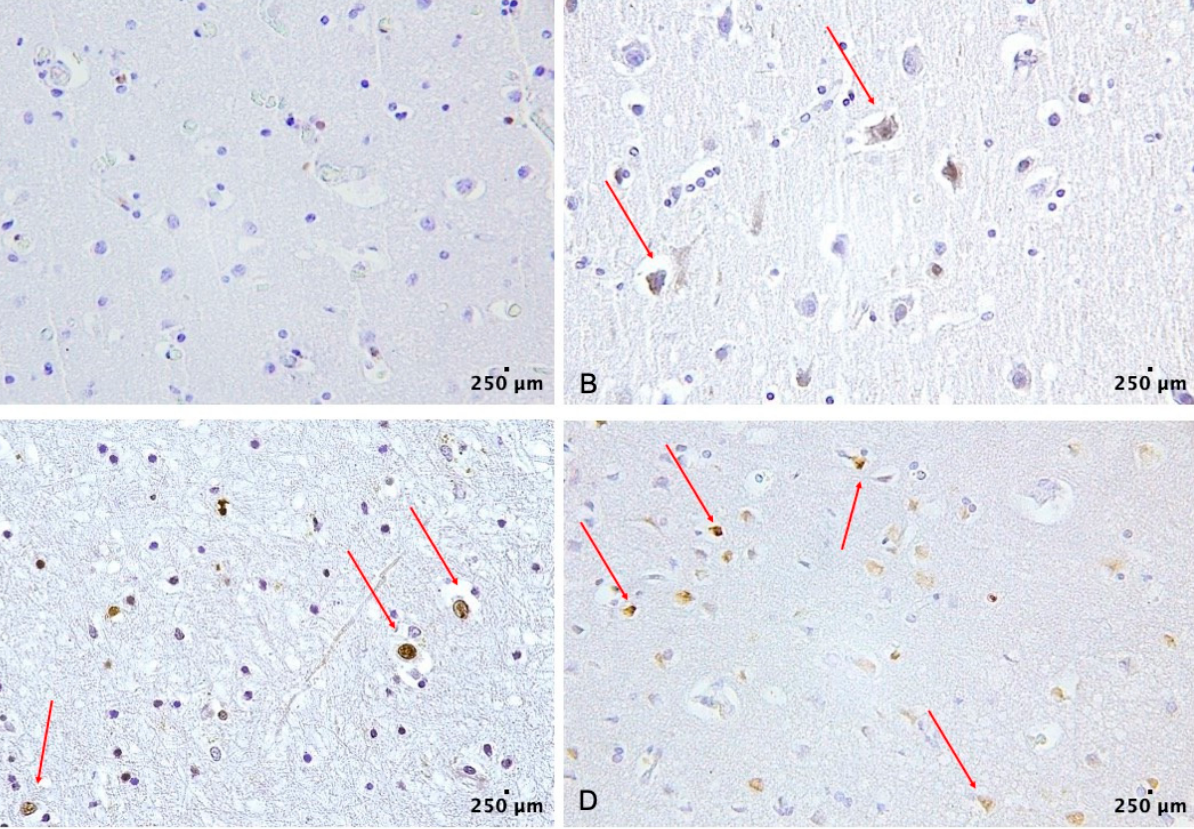
Figure 1. FOXO3a expression in the analyzed cerebral samples (red arrows). The scale bar showed 250 μ m in distance. ( A ) FOXO3a is negative (intensity score 0) (100×), ( B ) FOXO3a is positive (Inten- sity score 1) (100×), ( C ) FOXO3a is positive (intensity score 2) (100×), ( D ) FOXO3a is positive (inten- sity score 3) (100×), ( E ) FOXO3a is positive (intensity score 4) (100×).